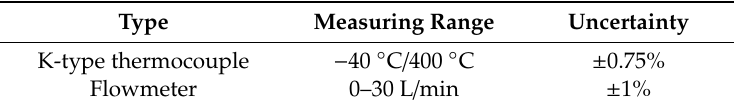
Table 1. The measurement devices used in the experimental